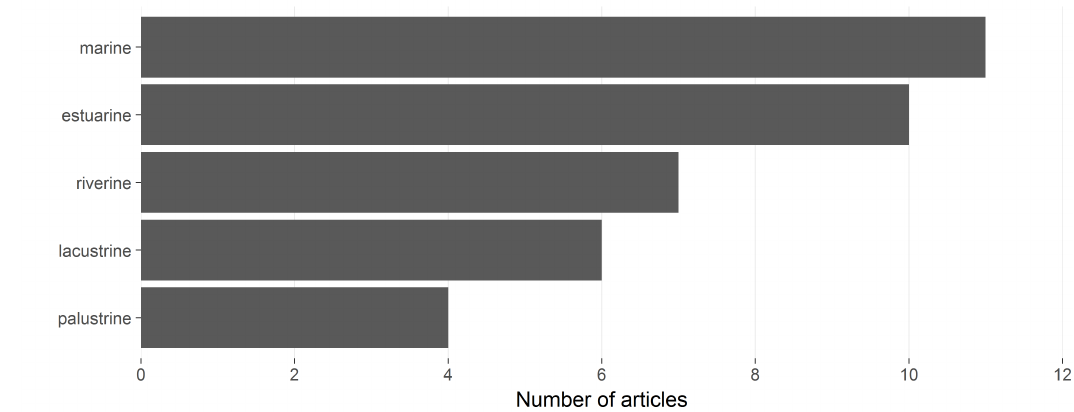
Figure 7. Number of studies categorized by wetland